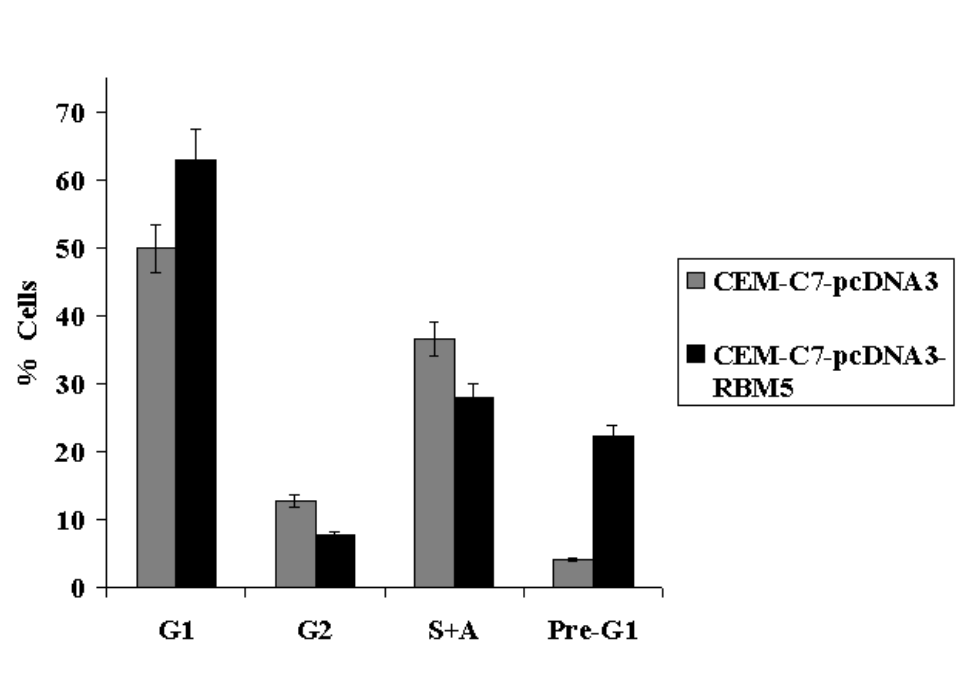
FIGURE 2 . LUCA-15/RBM5 is capable of inducing cell cycle arrest in G 1 -M and apoptosis. DNA content from CEM-C7/pcDNA3 and CEM-C7/pcDNA3-RBM5 was quantified by propidium iodide staining of fixed